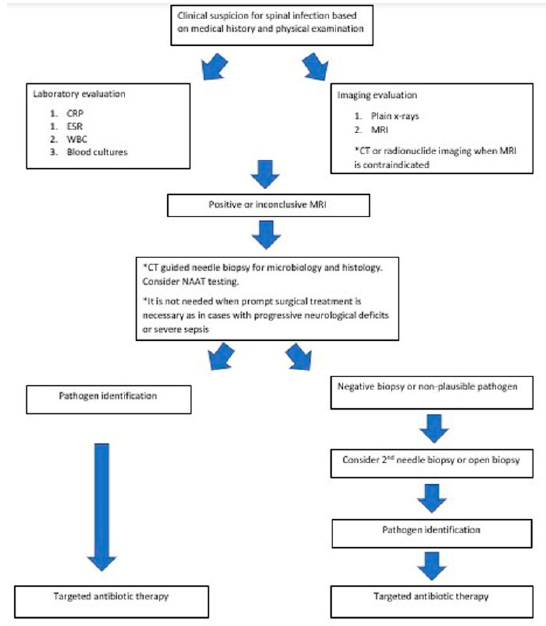
Figure 2. Diagnostic algorithm for spinal infections.